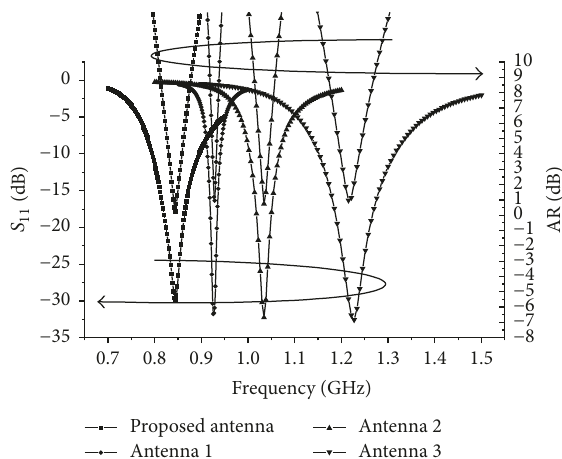
Figure 4: Simulated return losses and axial ratio of the proposed antenna and reference